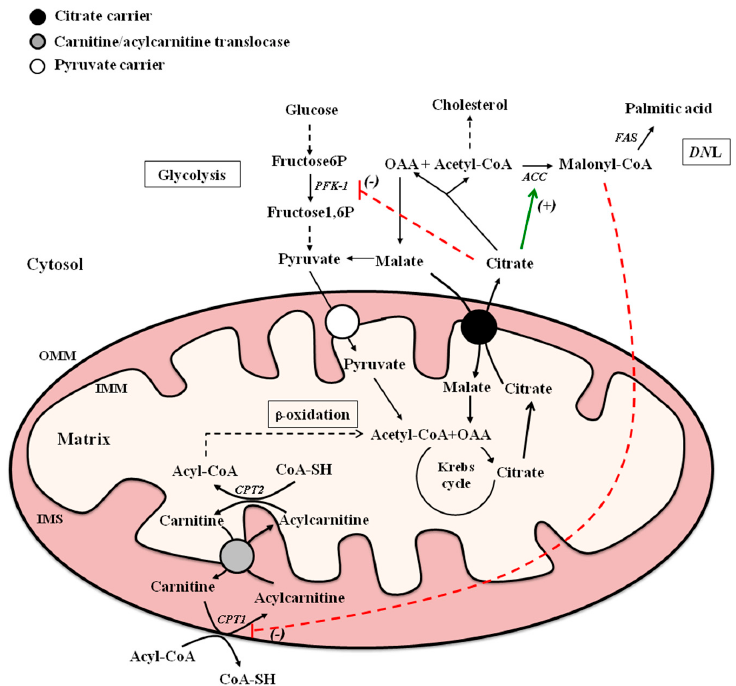
Figure 1. Schematic model of citrate carrier (CiC) and carnitine-acylcarnitine translocase (CACT) in lipogenesis and β -oxidation, and their metabolic interrelationship. Abbreviations: ACC, acetyl-CoA carboxylase; CoA-SH, coenzyme-A; CPT1, carnitine palmitoyltransferase 1; CPT2, carnitine palmitoyltransferase 2; DN L, de novo lipogenesis; FAS, fatty acid synthase; IMM, inner mitochondrial membrane; IMS, intermembrane space; OAA, oxaloacetate; OMM, outer mitochondrial membrane; PFK-1, phosphofructokinase-1. The green arrow and dashed red lines represent, respectively, positive (+) and negative (-) allosteric modulation of the indicated target enzymes.